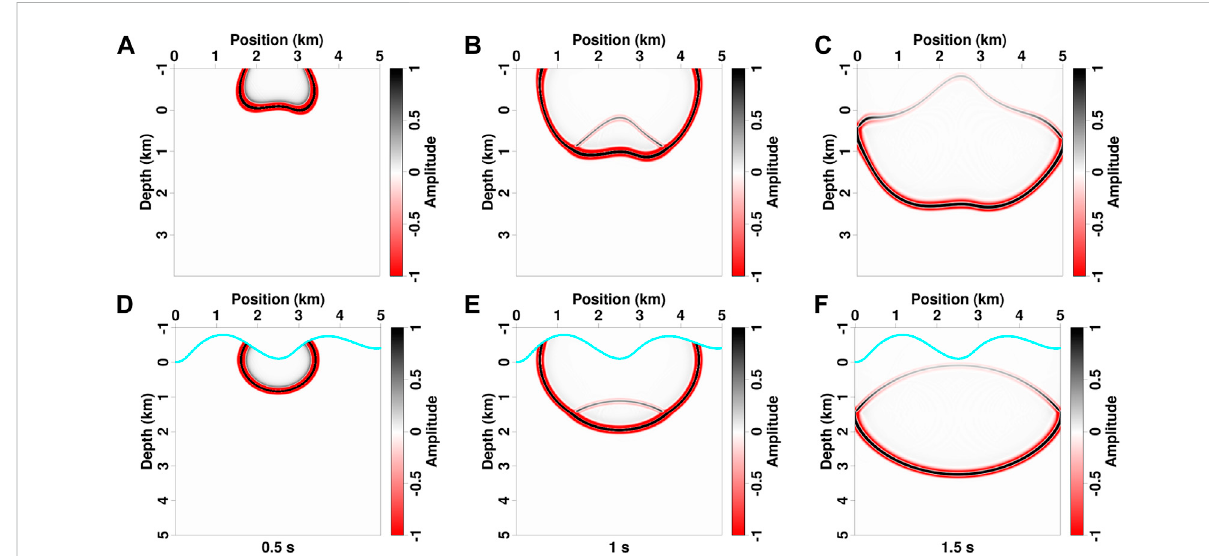
FIGURE 5 Viscoacousticwave fi eldsofdifferentpropagationtimeswithatopabsorption boundaryinthecomputationaldomain (A – C) andphysical space (D – F) . The cyan lines in panels (D – F) denote the topography.